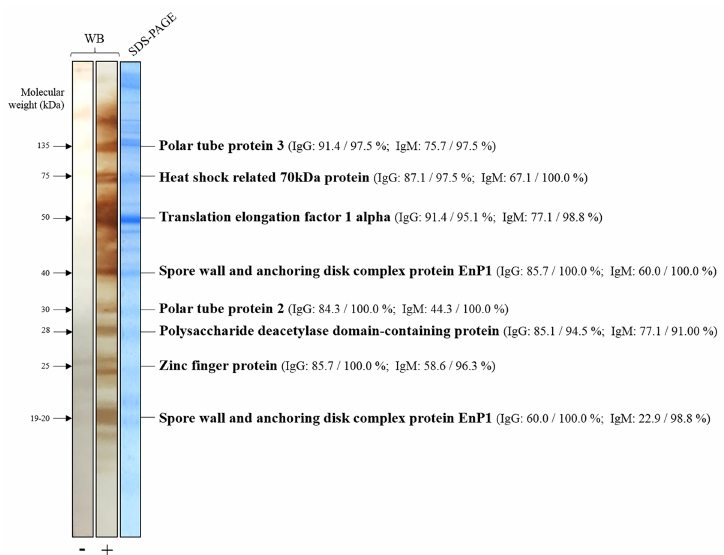
Fig 2. Example of negative and positive Western blot (WB) patterns for extracted Encephalitozoon cuniculi proteins using goat anti-rabbit IgG conjugate. The identification of the proteins in the SDS-PAGE gel (right panel)correspondingto the bands of interest on the WB (left panel) are listed on the right. In brackets: the respectivesensitivity and specificity for IgG and IgM detectionfor each WB band. The protein identifiedas spore wall and anchoringdisk complex protein EnP1 at 17–19 kDa was actually a fragment of the one found in 40 kDa. Abbreviations: -, Negative; +, Positive; kDa, Kilodalton;WB, Western blot.